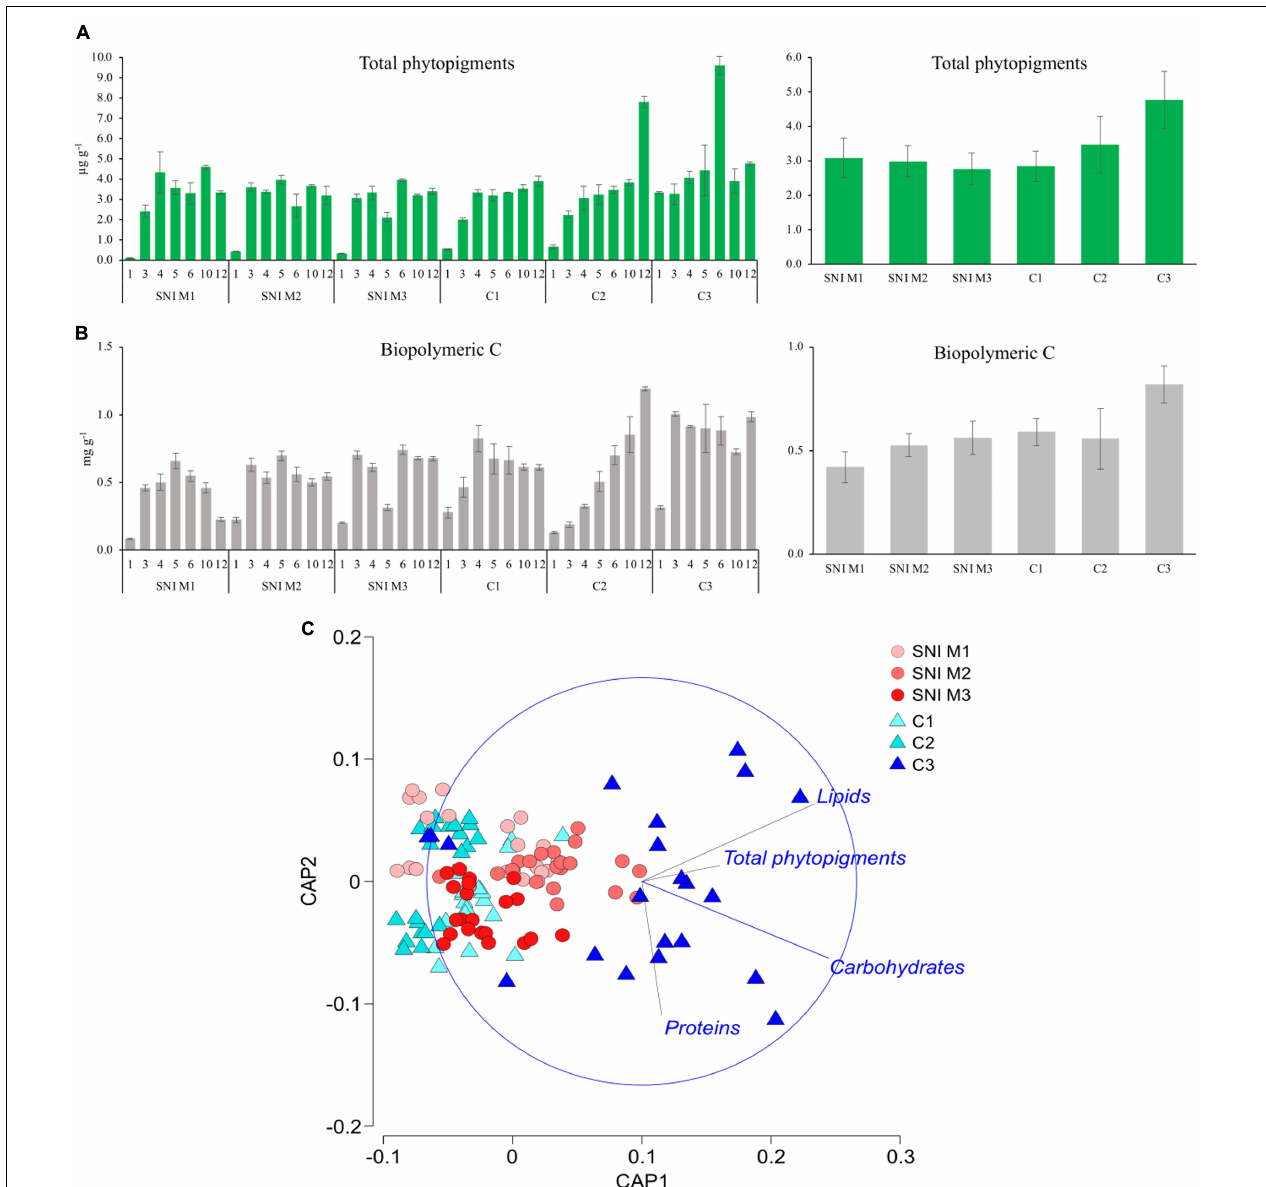
FIGURE 3 | Bathymetric distribution of biochemical components of the sedimentary organic matter in the SNI (M1, M2, and M3) and control (C1, C2, and C3) transects. (A) Phytopigment concentrations in the different stations and transects (on the left) and their average values (on the right), (B) BPC concentrations (on the left) and their average values (on the right), (C) output of canonical analysis of principal coordinates (CAP) based on organic matter biochemical components (protein, carbohydrate, lipid and total phytopigment